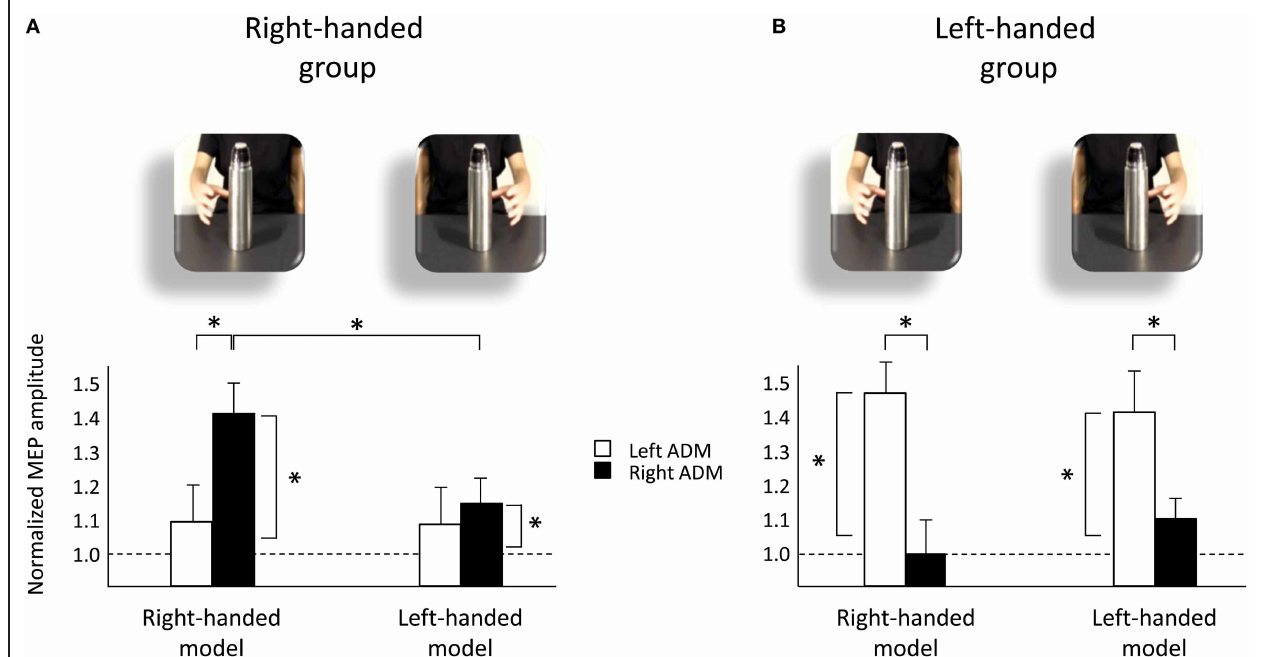
model, left-handed model) for right-handed (A) and left-handed (B) groups. Asterisks indicate significant comparisons ( p < 0 . 05). Bars represent the standard error of means. Horizontal dotted lines indicate MEP baseline